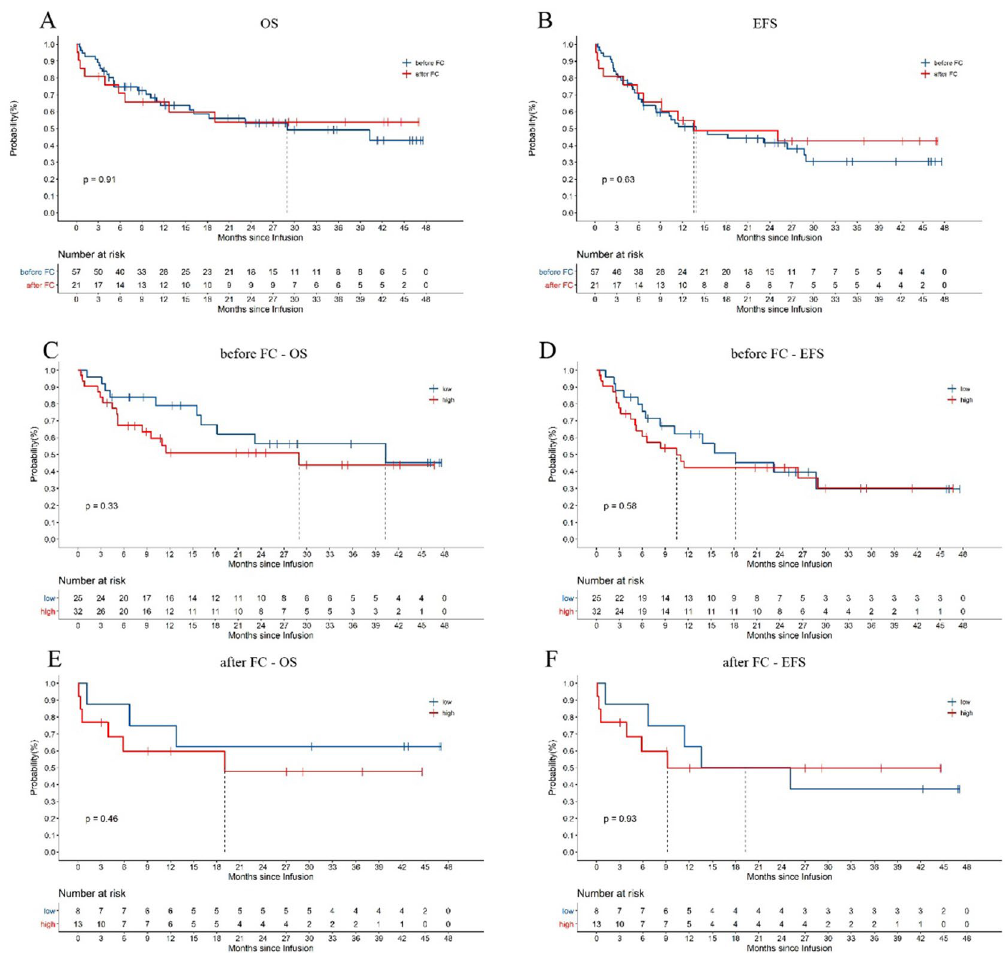
Figure 3. Long-term survival based on the tumor burden evaluation time point. ( A , B ) The OS and EFS, respectively, of patients who underwent bone marrow evaluations before and after interim therapy. ( C , D ) Correlations between OS or EFS and the tumor burden evaluated before FC treatment. ( E , F ) Correlations between OS or EFS and the tumor burden evaluated after FC